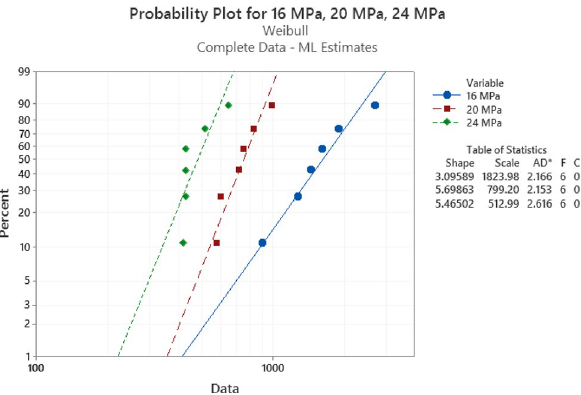
Figure 5. The Weibull probability plots for SAC305 solder joints cycled at − 10 °C and different load levels.